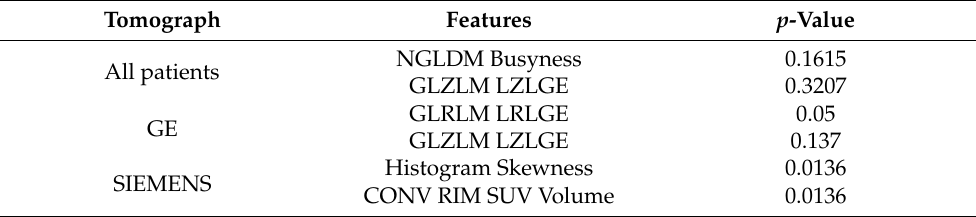
Table 2. Relevant features using the fixed ROI. NGLDM: neighbourhood grey-level different matrix; GLZLM LZLGE: grey-level zone length matrix long-zone low grey-level emphasis; GLRLM LRLGE: gray level run length matrix long run low grey-level emphasis; CONV RIM: Conventional ROI Intensity Mean.